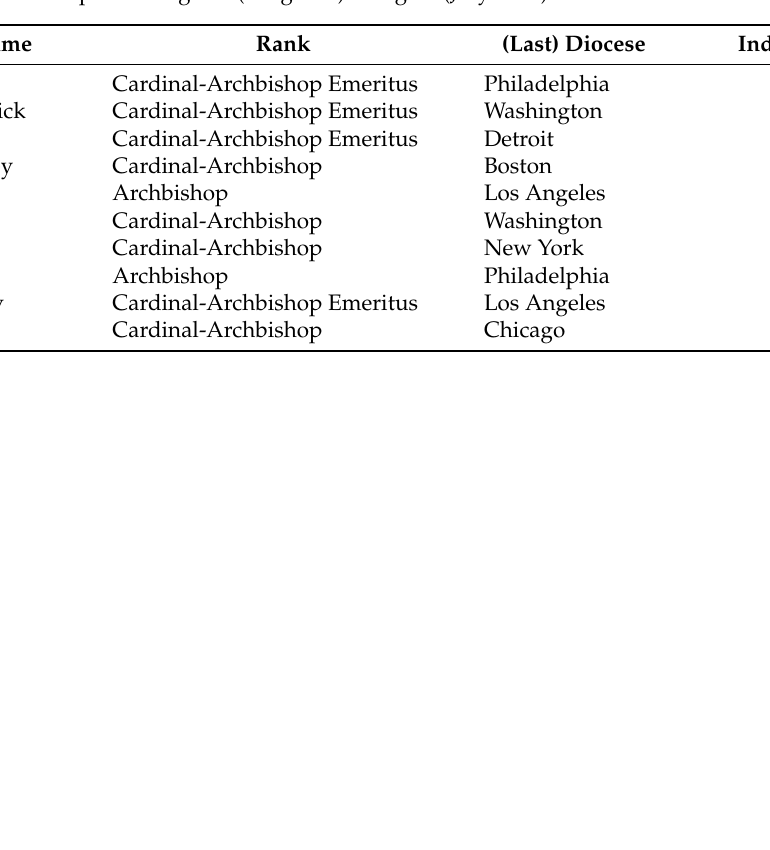
Table 2. US bishops with highest (weighted) indegree (July